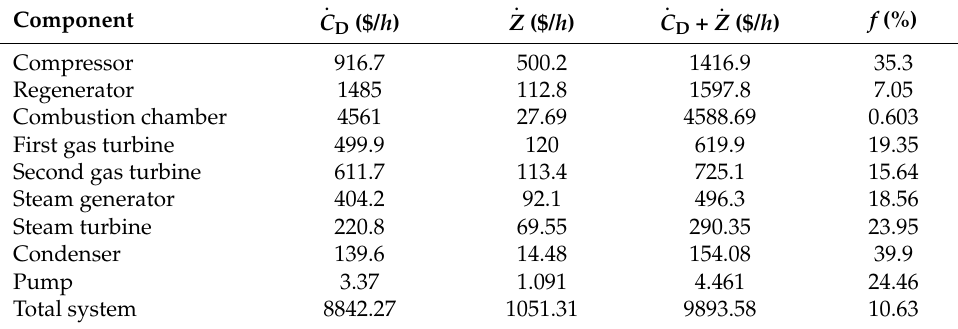
Table 14. Exergoeconomic analysis of Config.